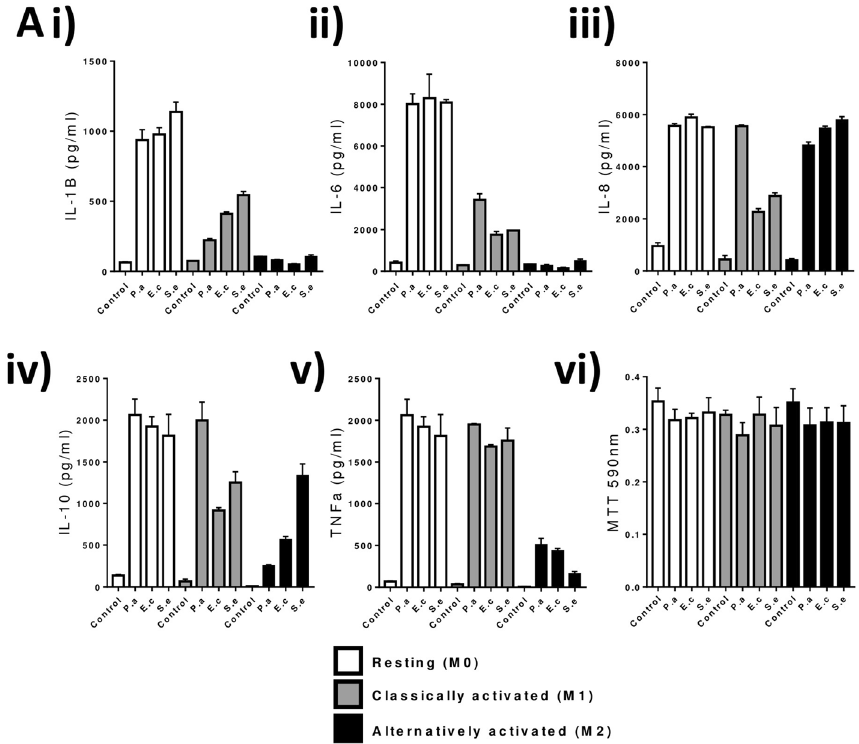
Figure 2. Differential M1 and M2 macrophage de novo NF-κB and IRF3 induction and cytokine production in response to LPS species. PMA differentiated THP-1 monocytes (Resting M0-Macrophages) were stimulated for 24hrs with either (50 ng/ml) recombinant human IFNγ (M1 polarization) or 25 ng/ml each of recombinant human IL-4 and IL-13 (M2). Macrophages were challenged with 1 ng/ml LPS in complete media for up to 24 h after which supernatants were collected for ( Ai – v ) multiplex cytokine (Il-1B, IL-6, IL-9, IL-10, TNFα), ( vi ) representative MTT viability assay experiment. Data is expressed as the mean ± SEM of 3 independent differentiations of THP-1 derived macrophages of passages 5–8. Mean ± SD is displayed for MTT. Statistical analysis performed on qPCR data was a multiple unpaired students t-tests comparing stimulated to control, **P < 0.01, ***P < 0.001, ****P <